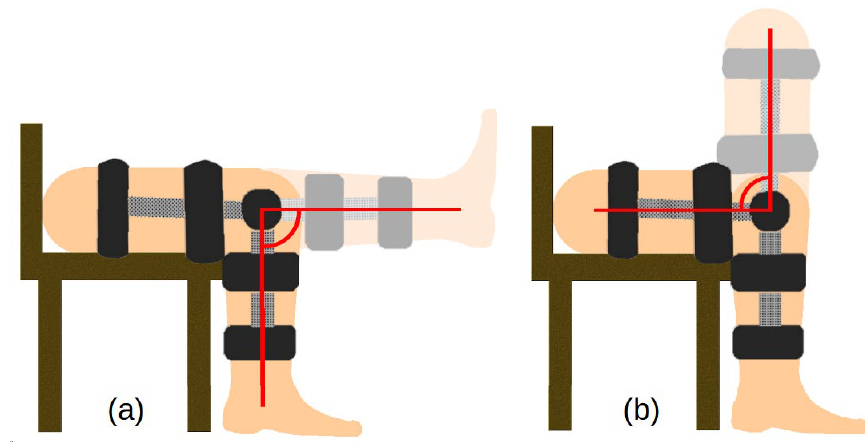
Figure 5. Leg movement in the open ( a ) and closed ( b ) kinematic chain.